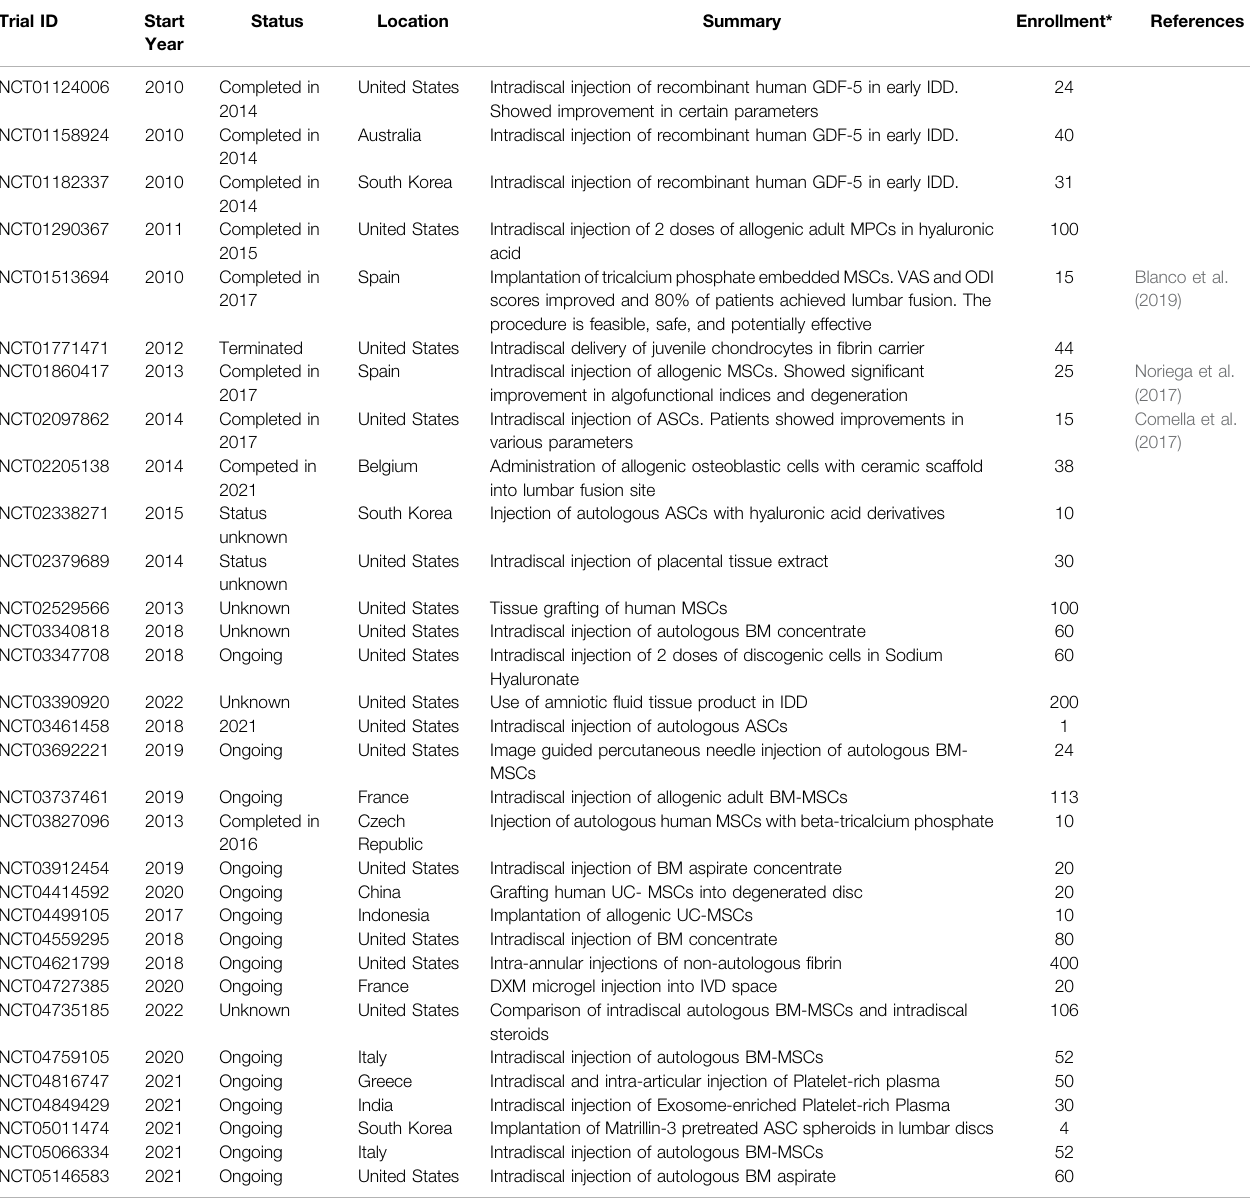
TABLE 2 | Summary of clinical trials for IVD treatment. Trial